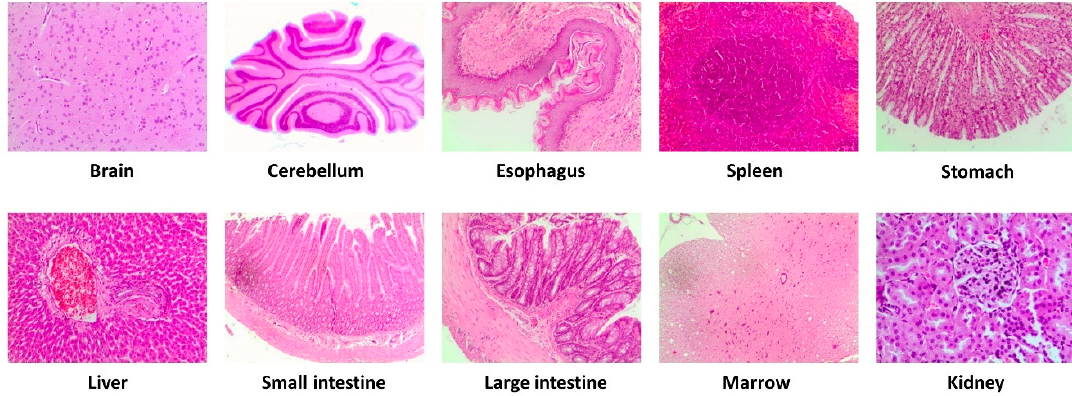
Figure 3. Representative microscopic evaluation (10×) of selected tissues after intervention with the high dose (2000 mg/kg/day) of a VOO extractin the study acute/subacute. Virgin olive oil (VOO).